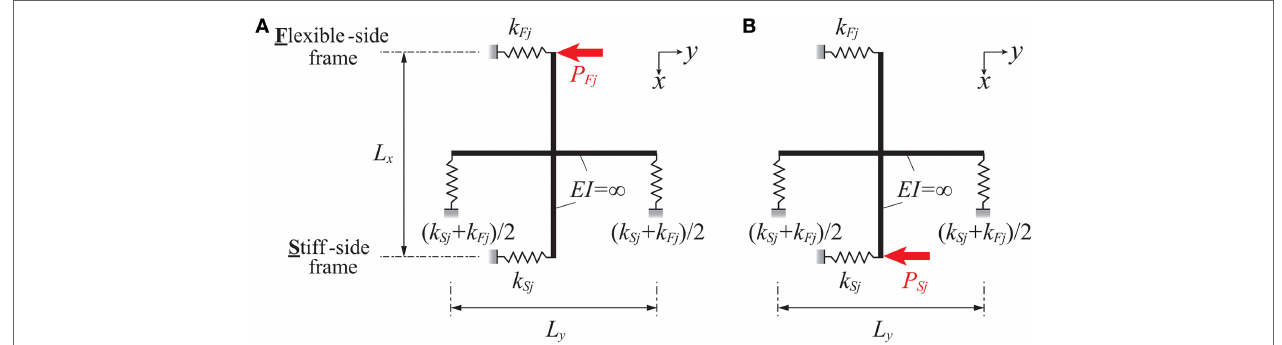
FIGURE 11 | Mechanical model and loading condition for horizontal stiffness identification, (A) loading case of P Fj , (B) loading case of P Sj .